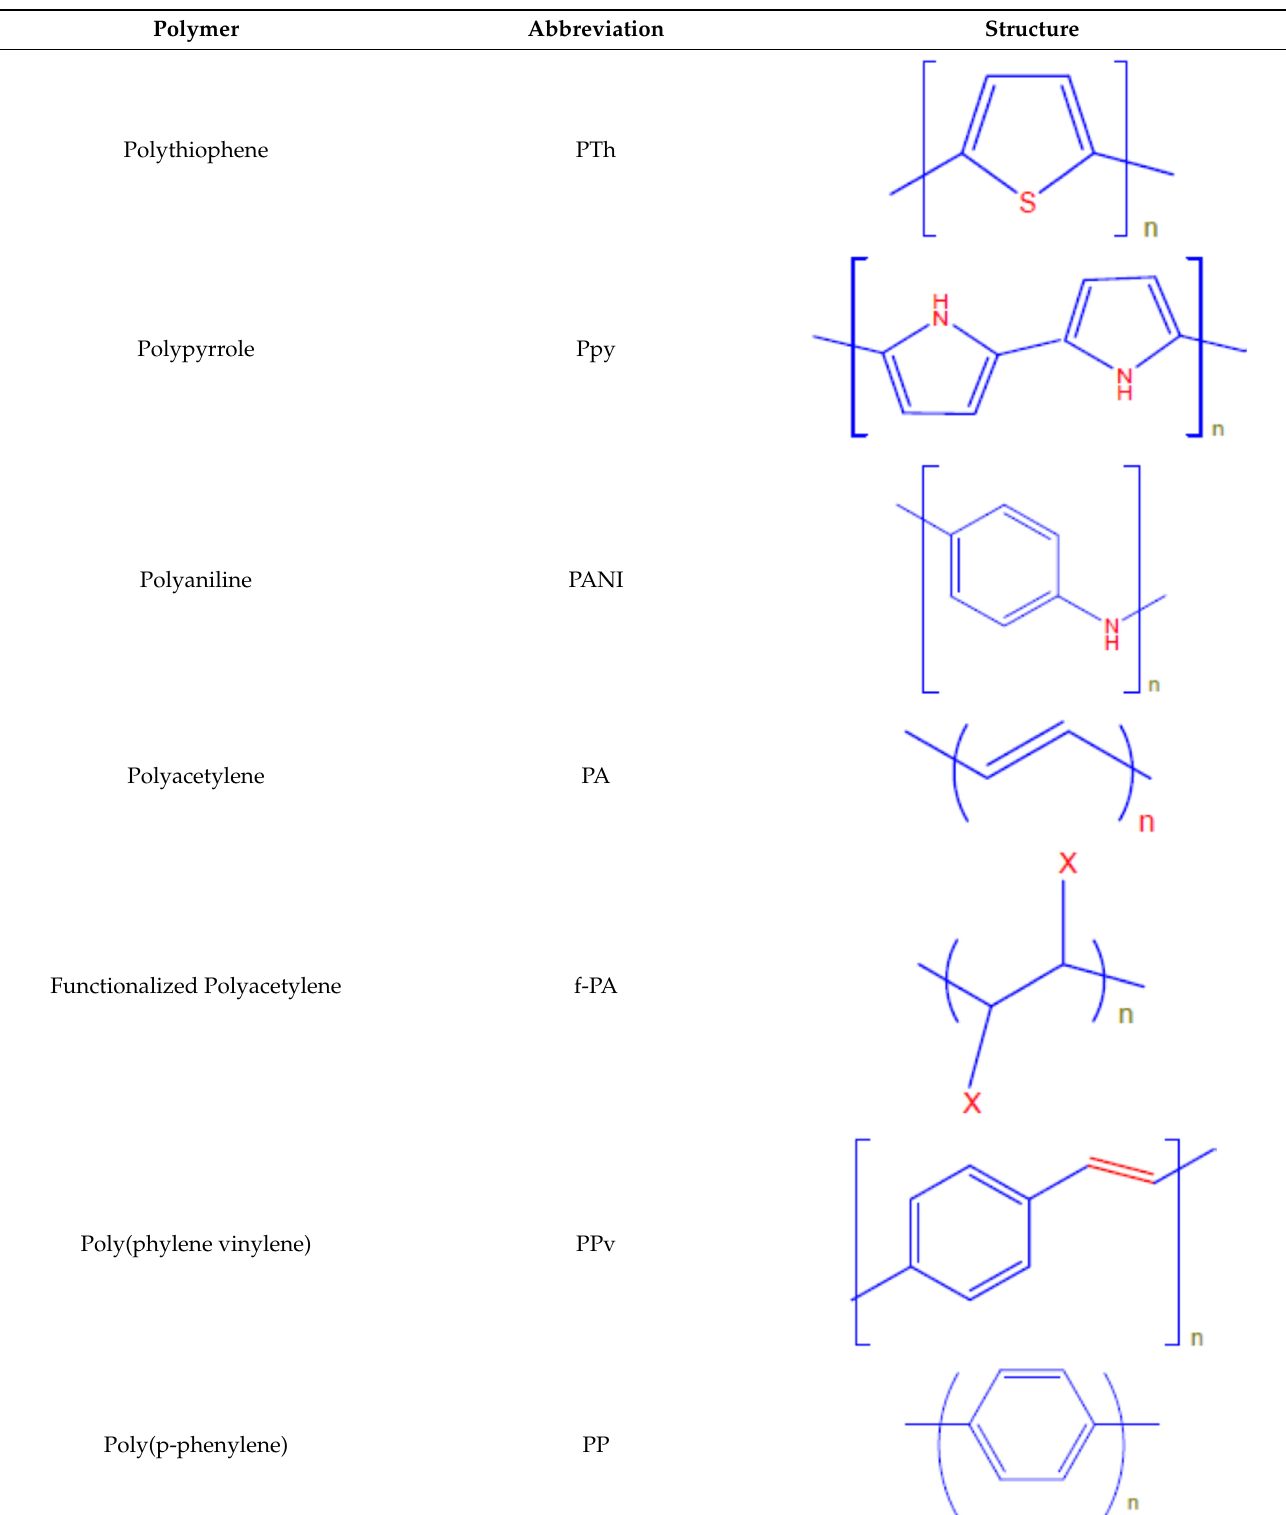
Table 1. Some conductive polymers and their chemical structures, Adapted from Ref. [6].